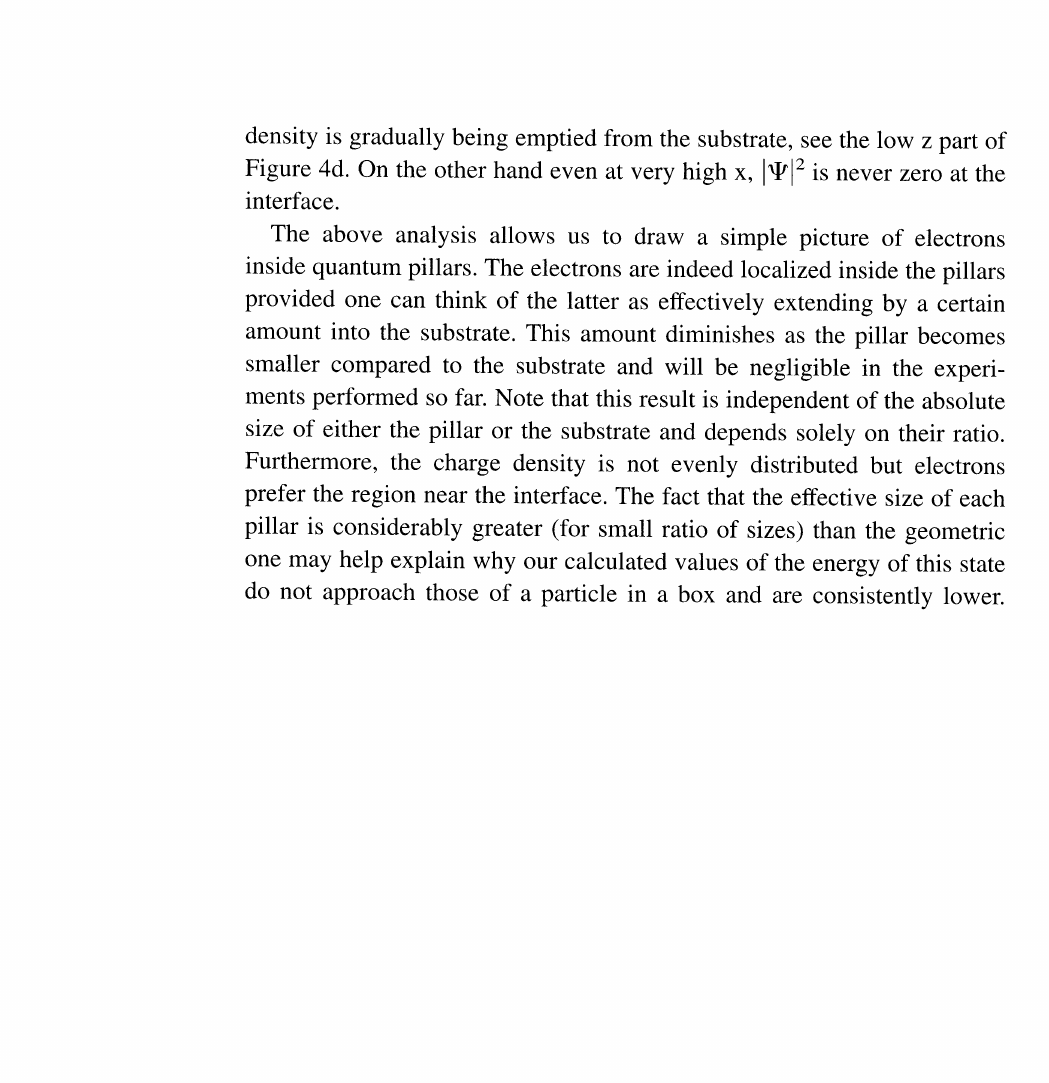
FIGURE 3 Variation of the energy of the lowest level localized in the smaller box w.r.t x as calculated by our method (solid curve) and assuming that the box is closed by all sides (broken curve). Units are as in Table